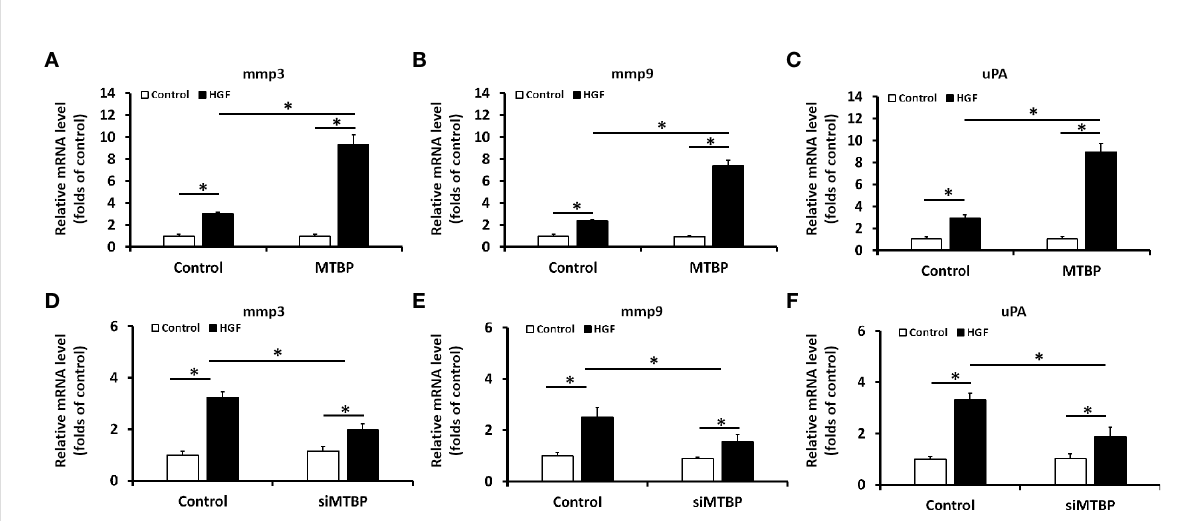
FIGURE 3 MTBP leads to enhancement of the mRNA level of ETS-1 ’ s downstream genes in HCC cells. (A – C) The effect of MTBP overexpression in MHCC97-L cells on the RNA level of ETS-1 ’ s downstream genes (A [mmp3]; B [mmp9]; C [uPA]) induced by HGF. (D – F) The effect of MTBP